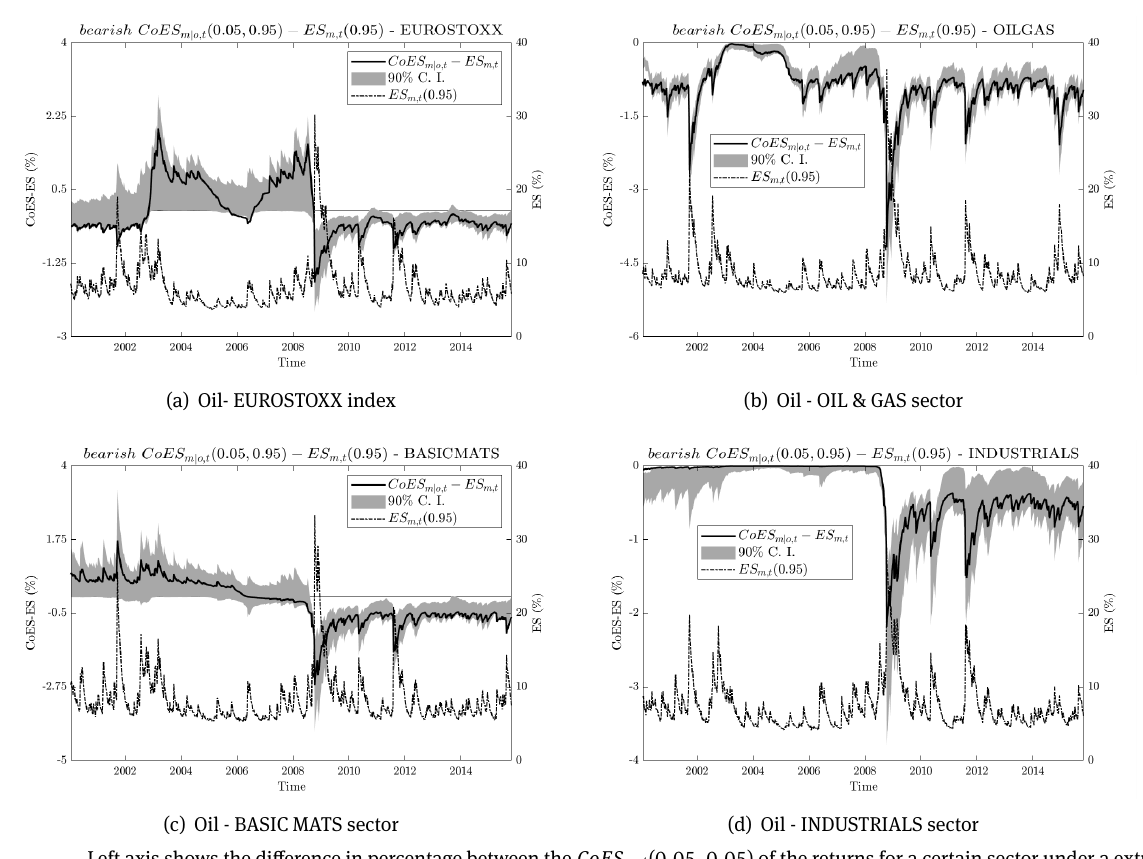
downward movement in oil prices, i.e. below its 5-th quantile, and its unconditional ES difference given the best copula mixture according to Table 6. Grey area indicates the 90% confidence interval of the difference between CoES (0.05, 0.95) and ES (0.05) following a Monte Carlo technique explained in Appendix C. The right axes m , t m | o , t shows the value of the ES (0.05) in percentage. The dash-dotted black line indicate the ES level over m , t